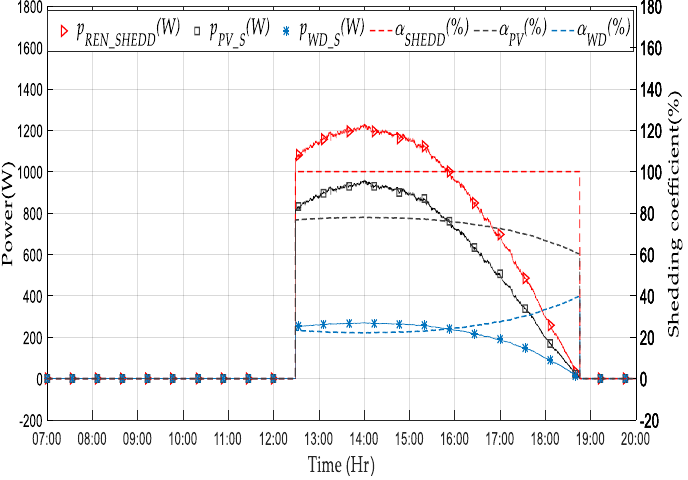
Figure 12. Power flow curves with optimization by applying the α coefficient.